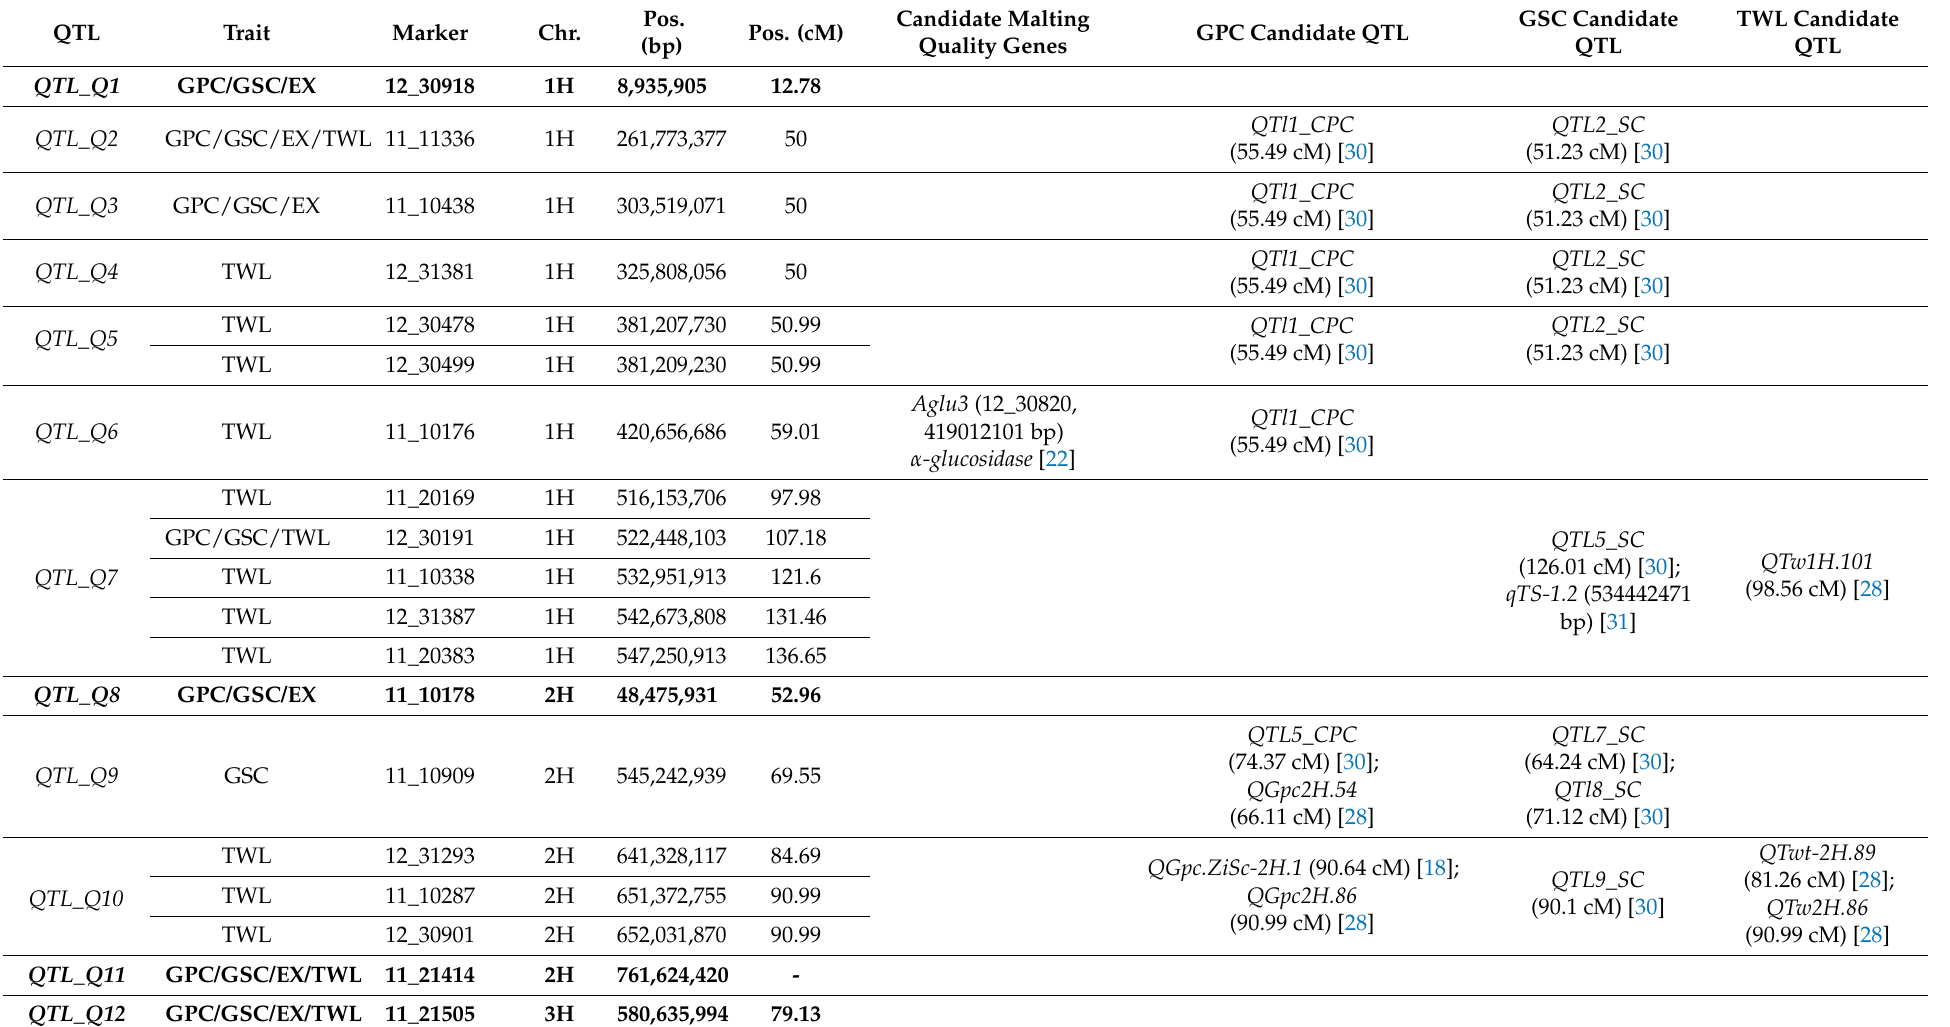
Table 2. List of identified QTLs for grain quality traits and their candidate loci. Novel QTLs are highlighted in